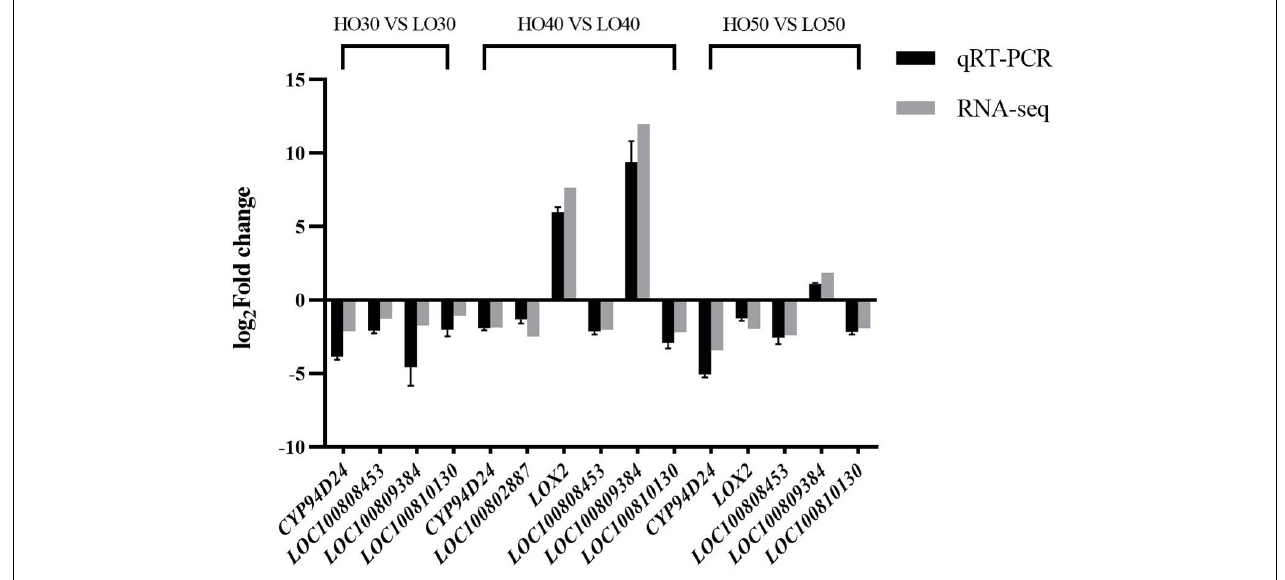
FIGURE 6 | The quantitative real time polymerase chain reaction verification of six genes related to fatty acid